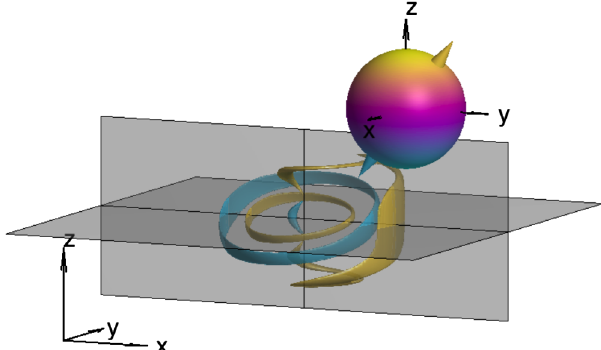
VIDEO 3. Preimages of different points on S 2 for vectorized n ð r Þ for a toron depicted in Fig. 11. Note that the linking of preimages changes at θ ¼ θ c .